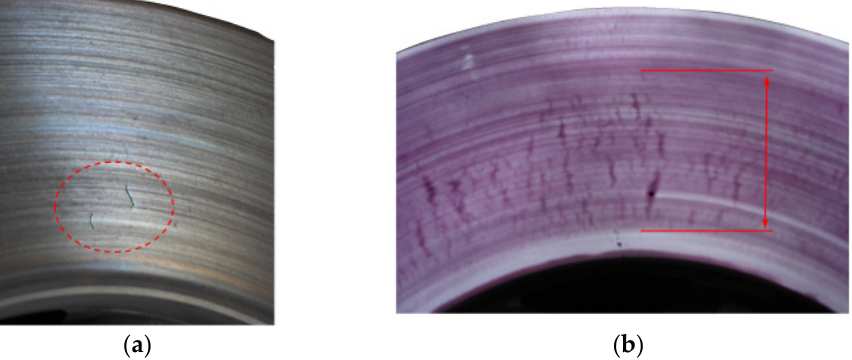
Figure 6. T2 (Grey Cast Iron) disc surface condition after successive braking (places of cracks marked red): ( a ) before penetration testing and ( b ) after penetration testing. Table 2. Chemical composition in % of elements for cast iron discs used during the